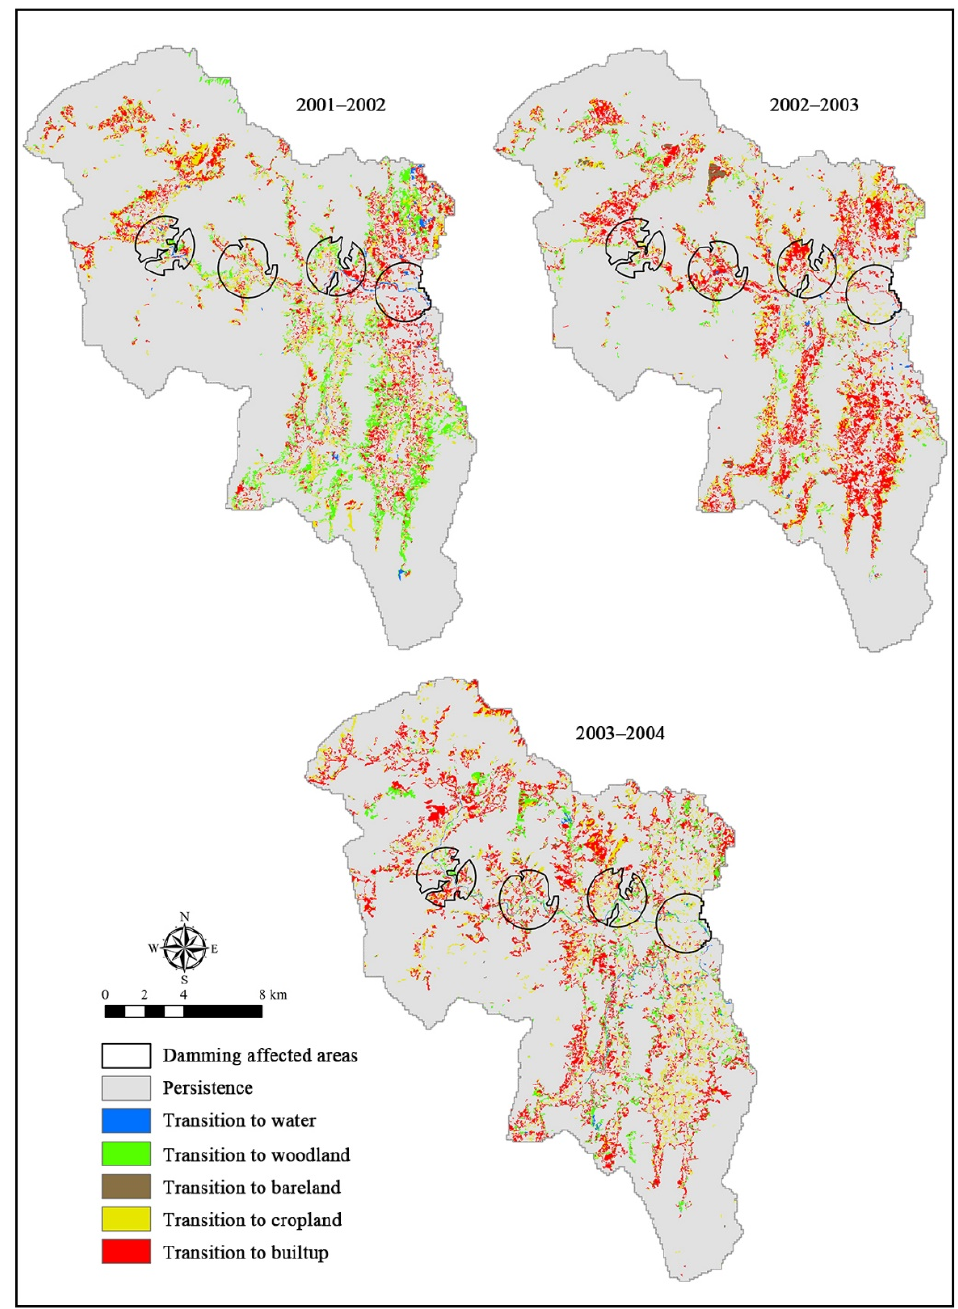
Figure 5. Land cover change analysis during three time intervals.